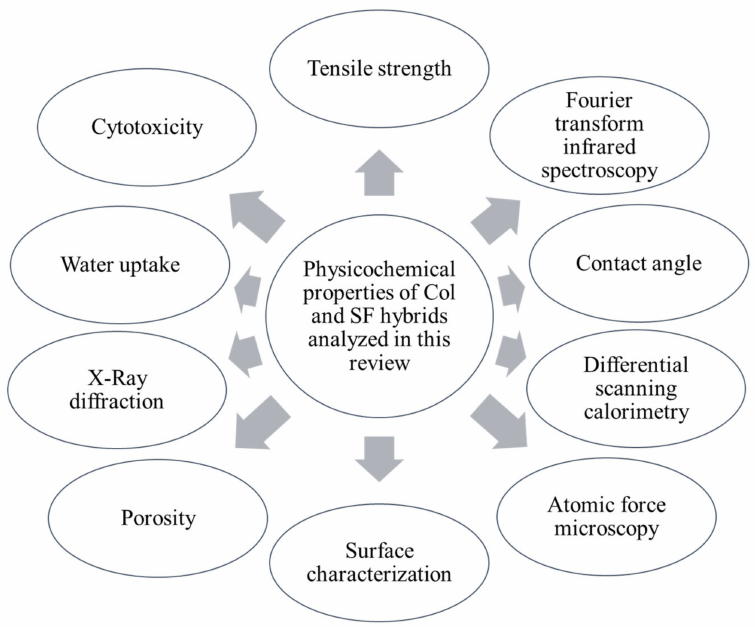
Figure 3. The essential physicochemical properties of collagen and silk fibroin hybrids analysed in this